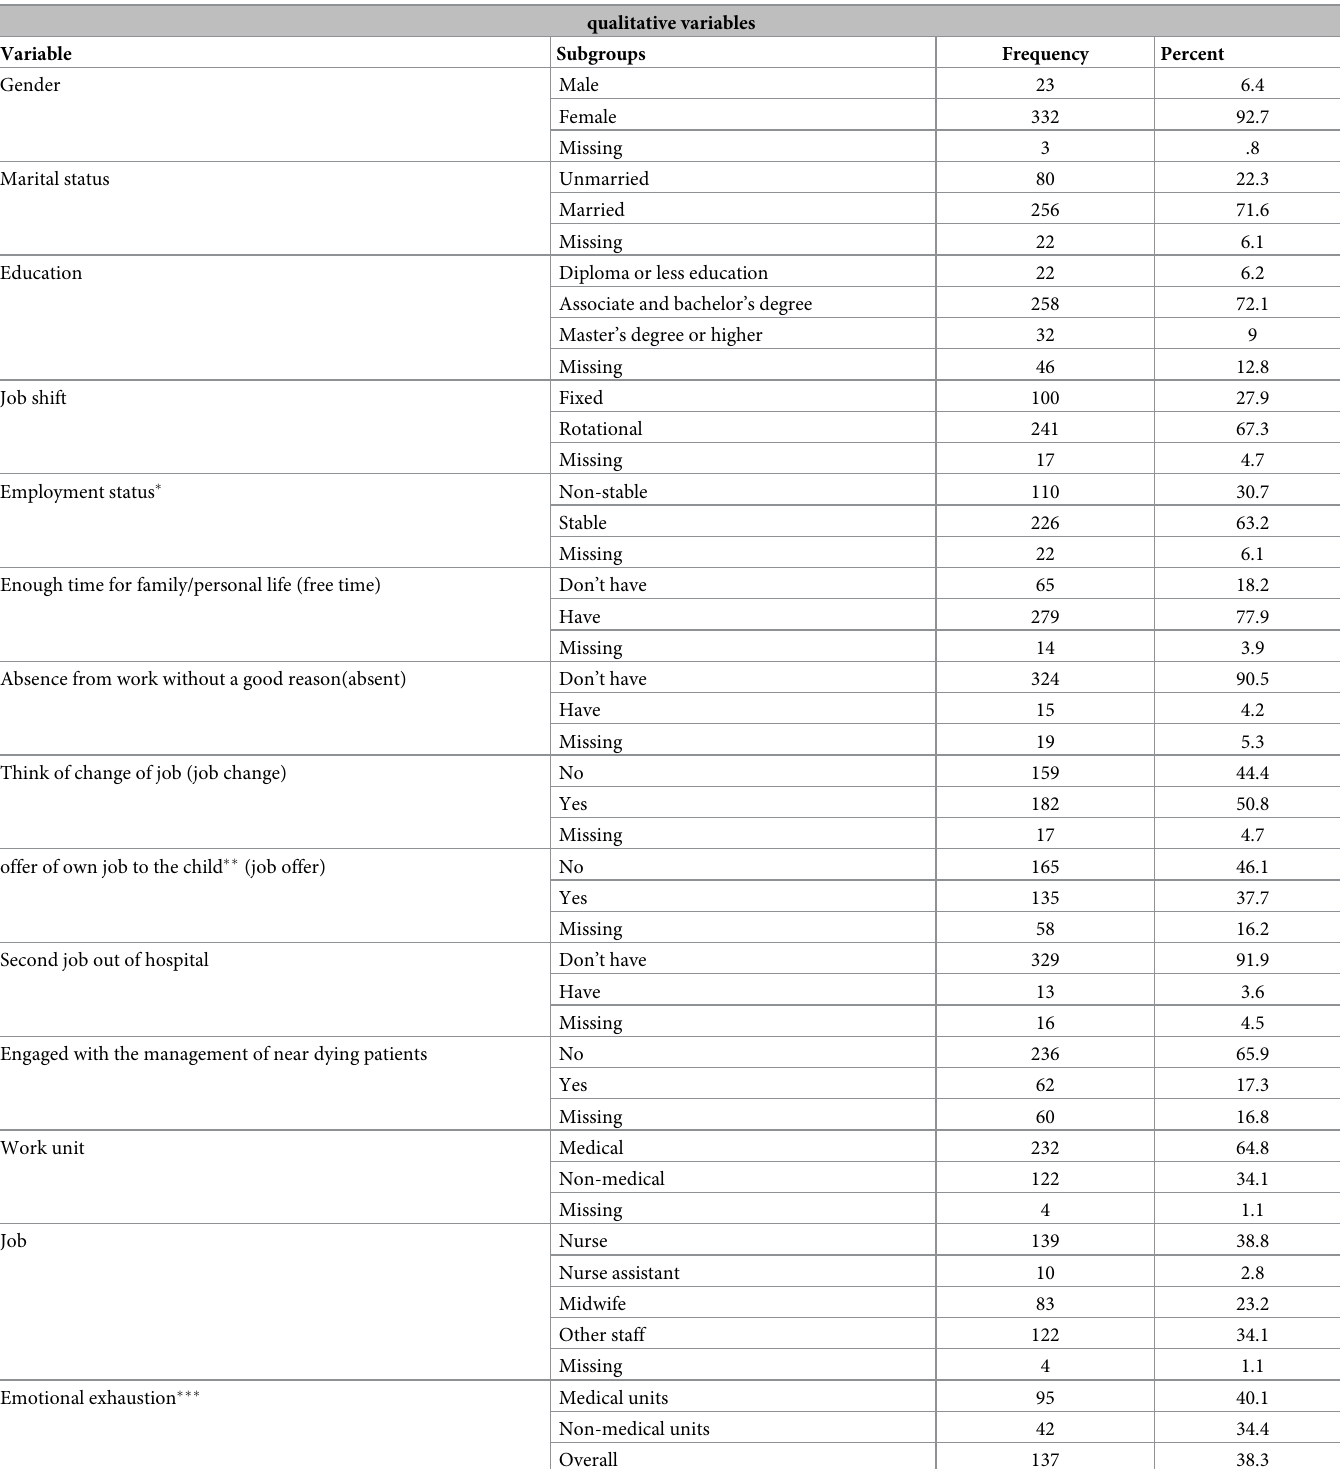
Table 2. Frequency of qualitative variables (n =